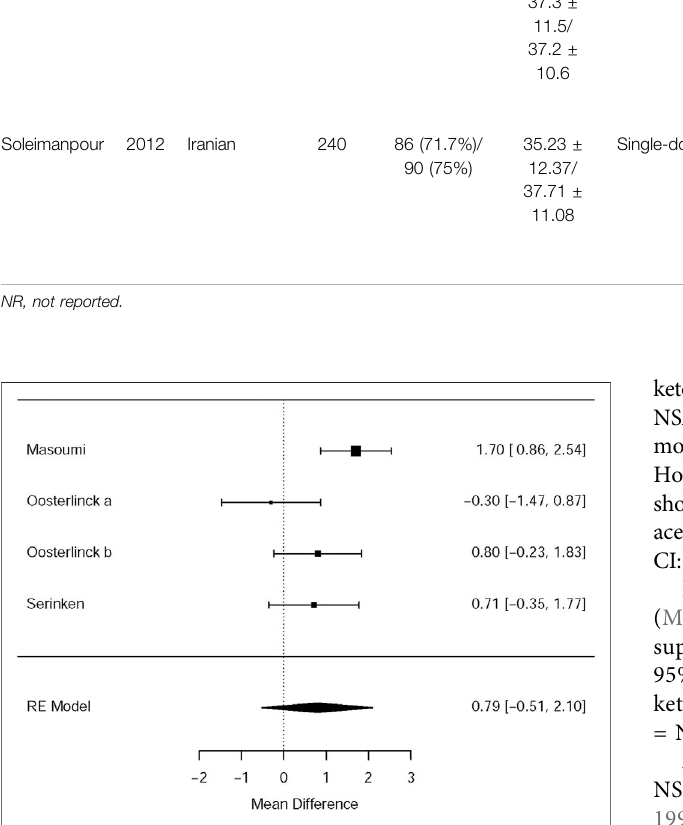
Table 4 reported the indicated signi fi cant differences on the VAS at 30 min for subjects with acute renal colic. They used